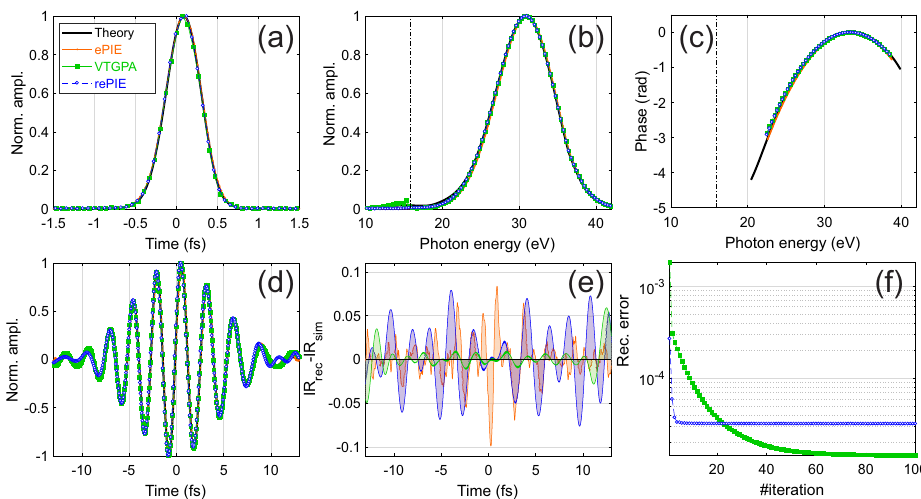
Figure 3. Attosecond pulses with spectrum centred around the 21st harmonic. ( a ) Temporal amplitude profile of the XUV pulse. ( b , c ) Associated spectra amplitude and phase. ( d ) Reconstructed IR femtosecond pulse. ( e ) Residual error between the simulated and reconstructed IR pulse. ( f ) Reconstruction error of the last 100 iterations for VTGPA and rePIE algorithms as a function of iteration number. In all the figures, orange full dots represent the ePIE results, green squared marks show the VTGPA results, while the rePIE output is represented by the blue open